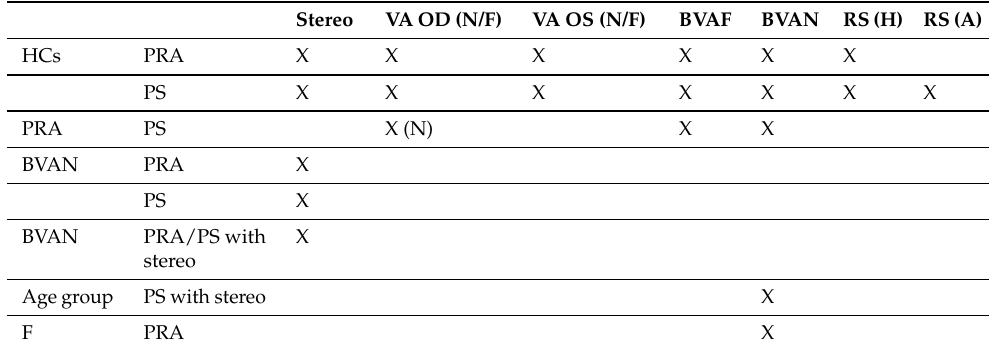
Table 4. A summary of the statistically significant differences for the visual performance among